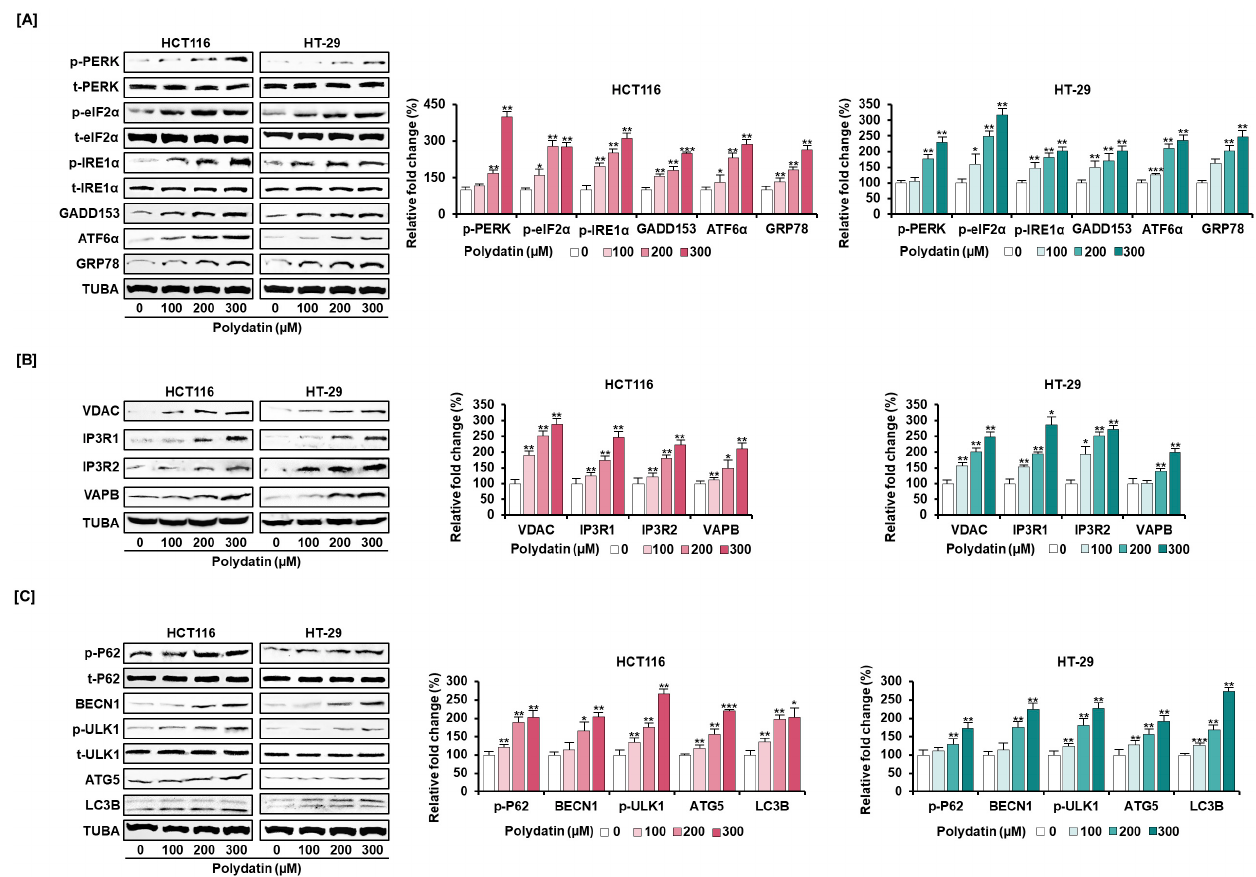
Figure 5. Dose-dependent stimulatory effects of polydatin on protein levels related to anticancer ability. ( A ) The protein expression of ER stress inducers—PKR-like ER-resident kinase (p-PERK), inositol-requiring enzyme 1 α (IRE1 α ), and activating transcription factor 6 α (ATF6 α ), ER stress sensor—eukaryotic translation-initiation factor 2 α (p-eIF2 α ), and growth arrest and DNA damage-inducible gene 153 (GADD153), and the upregulation protein of ER stress sensor—glucose-regulated protein 78 (GRP78), when HCT116 and HT-29 cells were treated with diverse concentrations of polydatin. ( B ) Effects of polydatin on ER-mitochondria-tethering proteins (VDAC, IP3R1, IP3R2, and VAPB) in HCT116 and HT-29 cells by Western blotting. ( C ) The protein levels of phosphorylated P62 (p-P62), beclin-1 (BECN1), phosphorylated UNC-51-like kinase 1 (p-ULK1), autophagy-related 5 (ATG5), and microtubule-associated proteins 1A/1B light chain 3B (LC3B) implicated in autophagy. The expression of each protein was normalized compared with TUBA or each total protein. The asterisks mean statistical variation between polydatin-treated and DMSO-treated groups (* p < 0.05, ** p < 0.01, and *** p < 0.001).